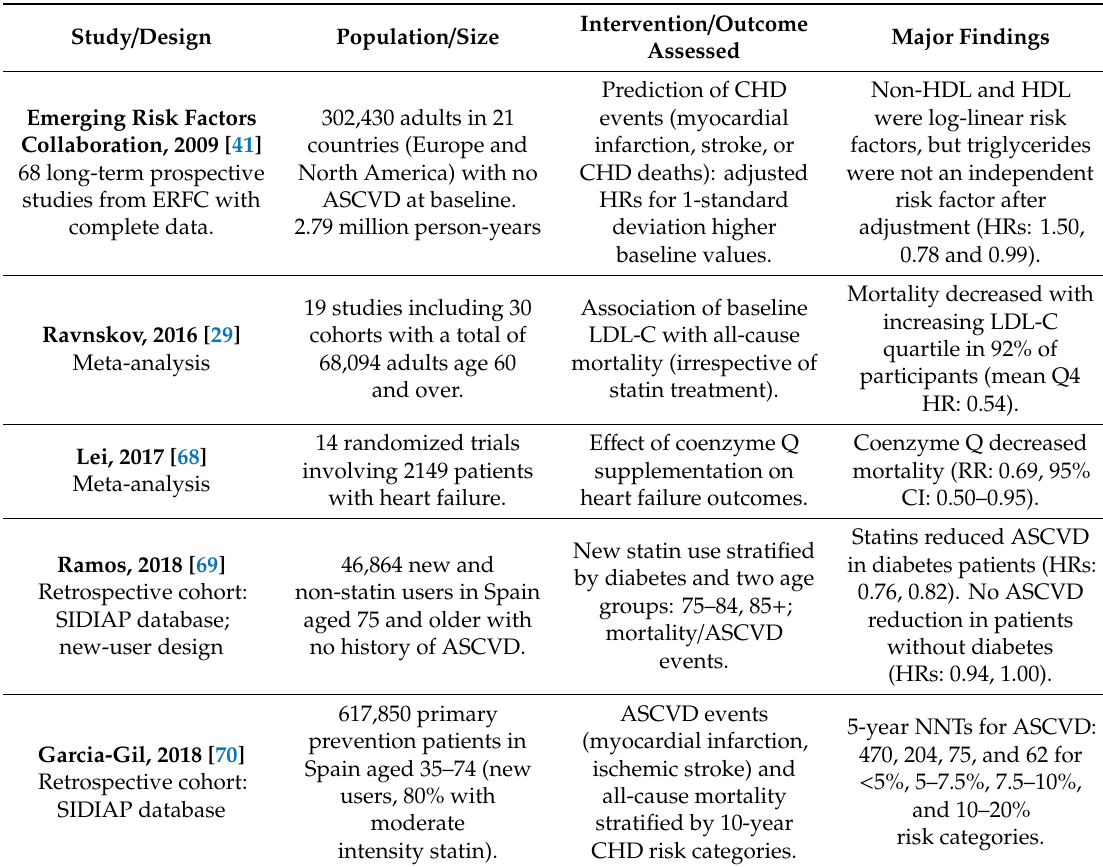
Table 1. Large-scale clinical studies of significant interest: role of lipid levels, treatment intervention, and biomarkers in distinct patient